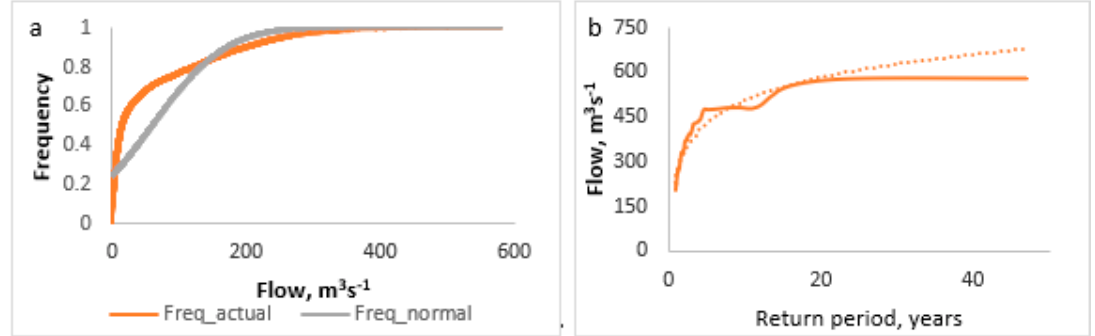
Figure 3. Cumulative Distribution Function ( a ) and Flood Frequency ( b ) Curves of Gumara River at the outlet. The orange line is the actual frequency and the grey line is the normal frequency. The actual frequency is the frequency of a flow value, indicating the number of data at or below it. The normal frequency is the predicted frequency for the normal distribution of the data. The solid line in the Flood Frequency curve is the actual flood flow versus return period and the dotted line is the logarithmic curve fit to estimate flood magnitude at a given return period.